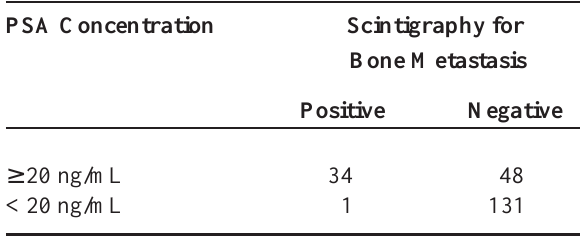
Table 2 – Relationship between prostate specific antigen (PSA) concentrations, cutting point of 20 ng/mL, and presence of bone metastasis in scintigraphy for patients with prostate